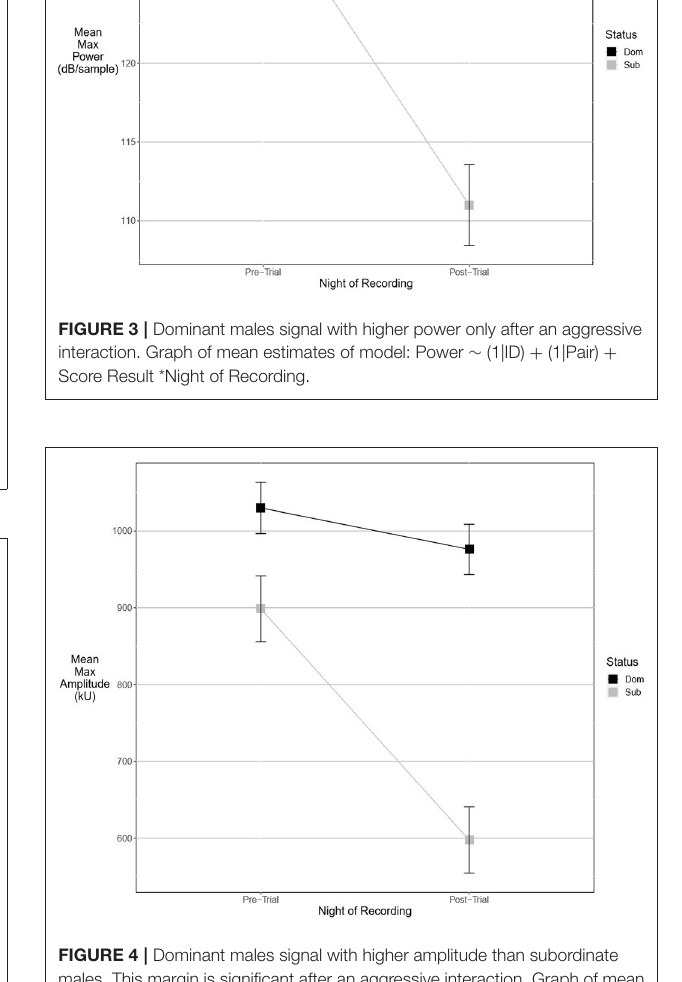
A model containing an aggression variable best predicted